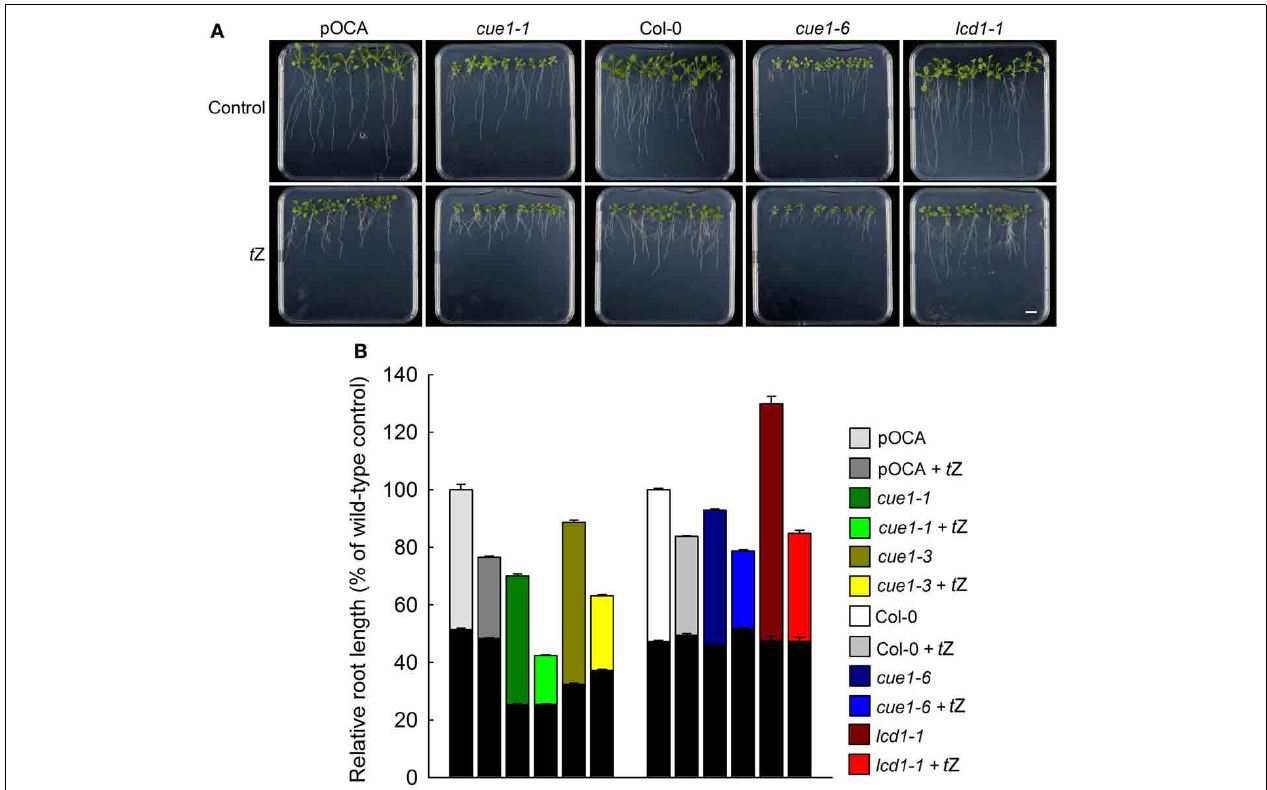
FIGURE 8 | Root phenotypes seven days after feeding of Col-0, pOCA, cue1-1 , cue1-6 and lcd1-1 with t Z. The plants were grown for three weeks on ½MS agar and were then transferred to ½MS agar supplemented with the effector (1 μ M). (A) Phenotypic appearance including root lengths of wild-type/control and mutant plants seven days after start of feeding with AAA (the bar indicates a distance of 1cm). (B) Relative root lengths of pOCA, cue1-1 , cue1-3 , Col-0, cue1-6 , and